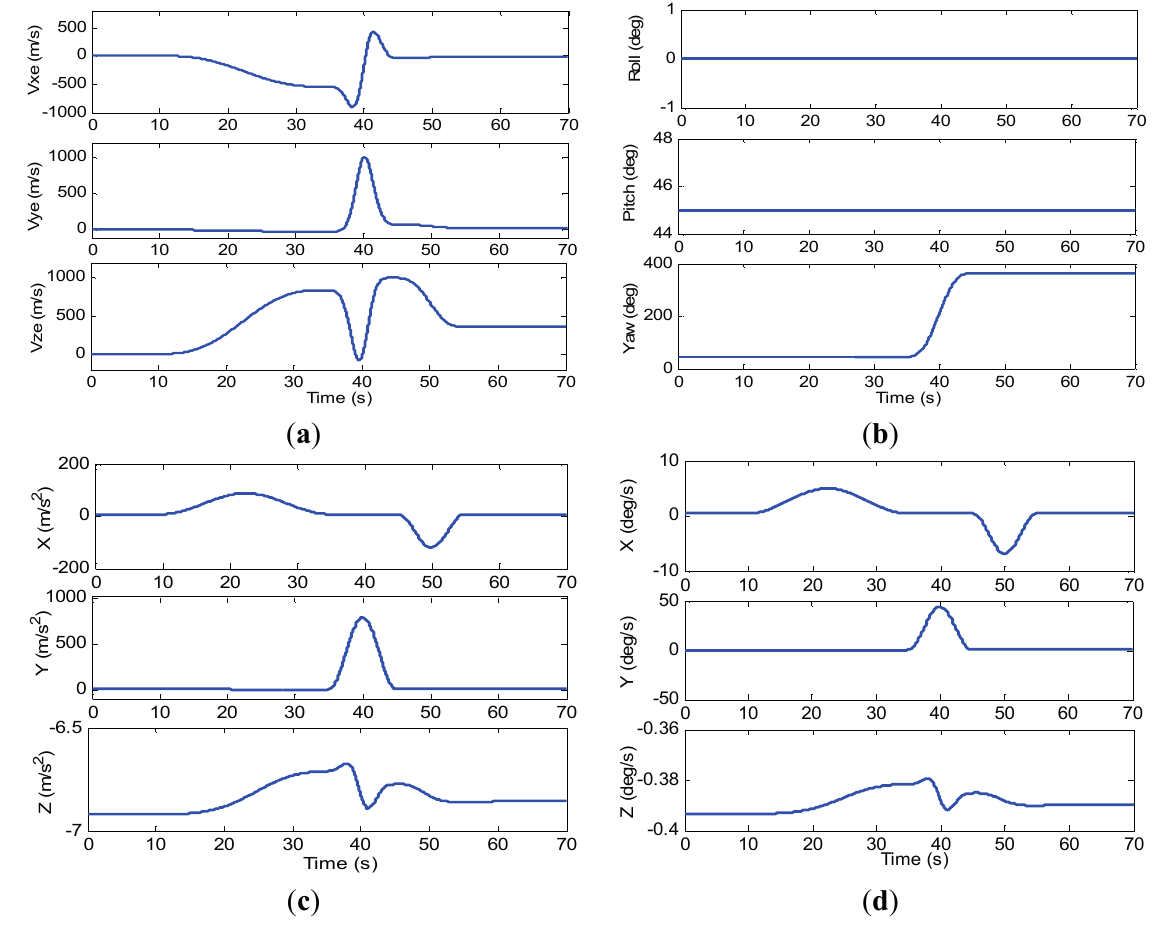
Figure 3. ( a ) Velocity of the aircraft in earth-centered earth-fixed (ECEF); ( b ) Attitude of the aircraft; ( c ) Specific force of the aircraft in b frame; and ( d ) G-sensitivity errors of the